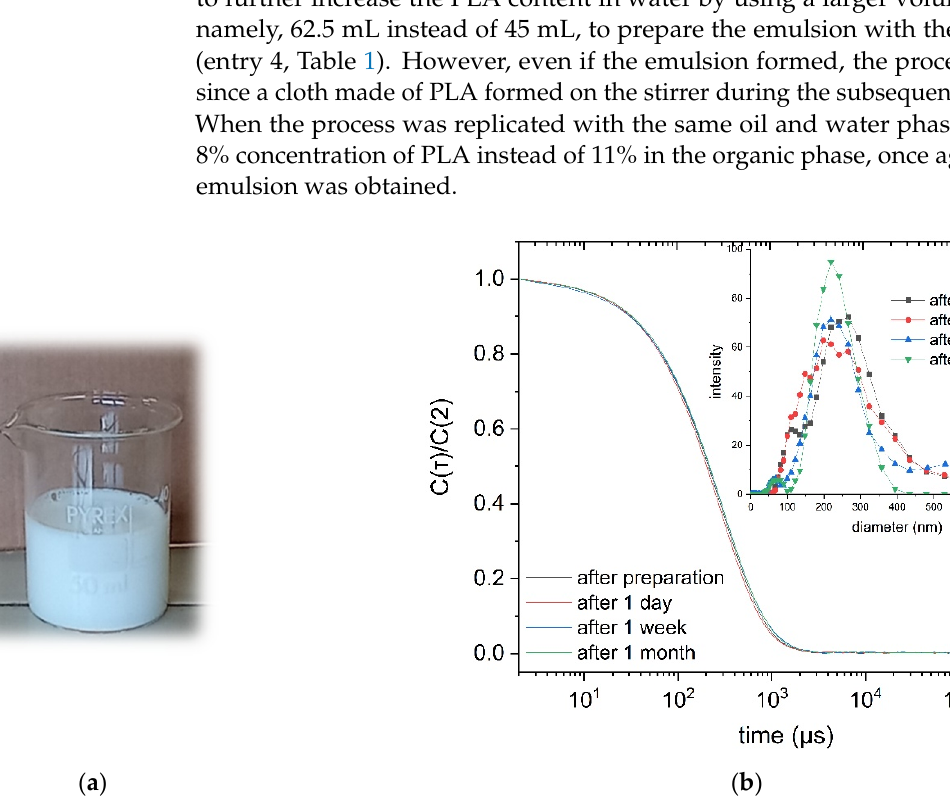
Figure 1. ( a ) Picture of the PLA dispersion of entry 5, Table 1; ( b ) comparison between DLS plots of the PLA dispersions prepared under the condition of entry 3, Table 1, after storing for increasing periods of time. Correlograms are normalized with respect to the intensity at time 2 µs. Insert refers to the particle size distribution as obtained by data fitting with a multimodal size distribution function.